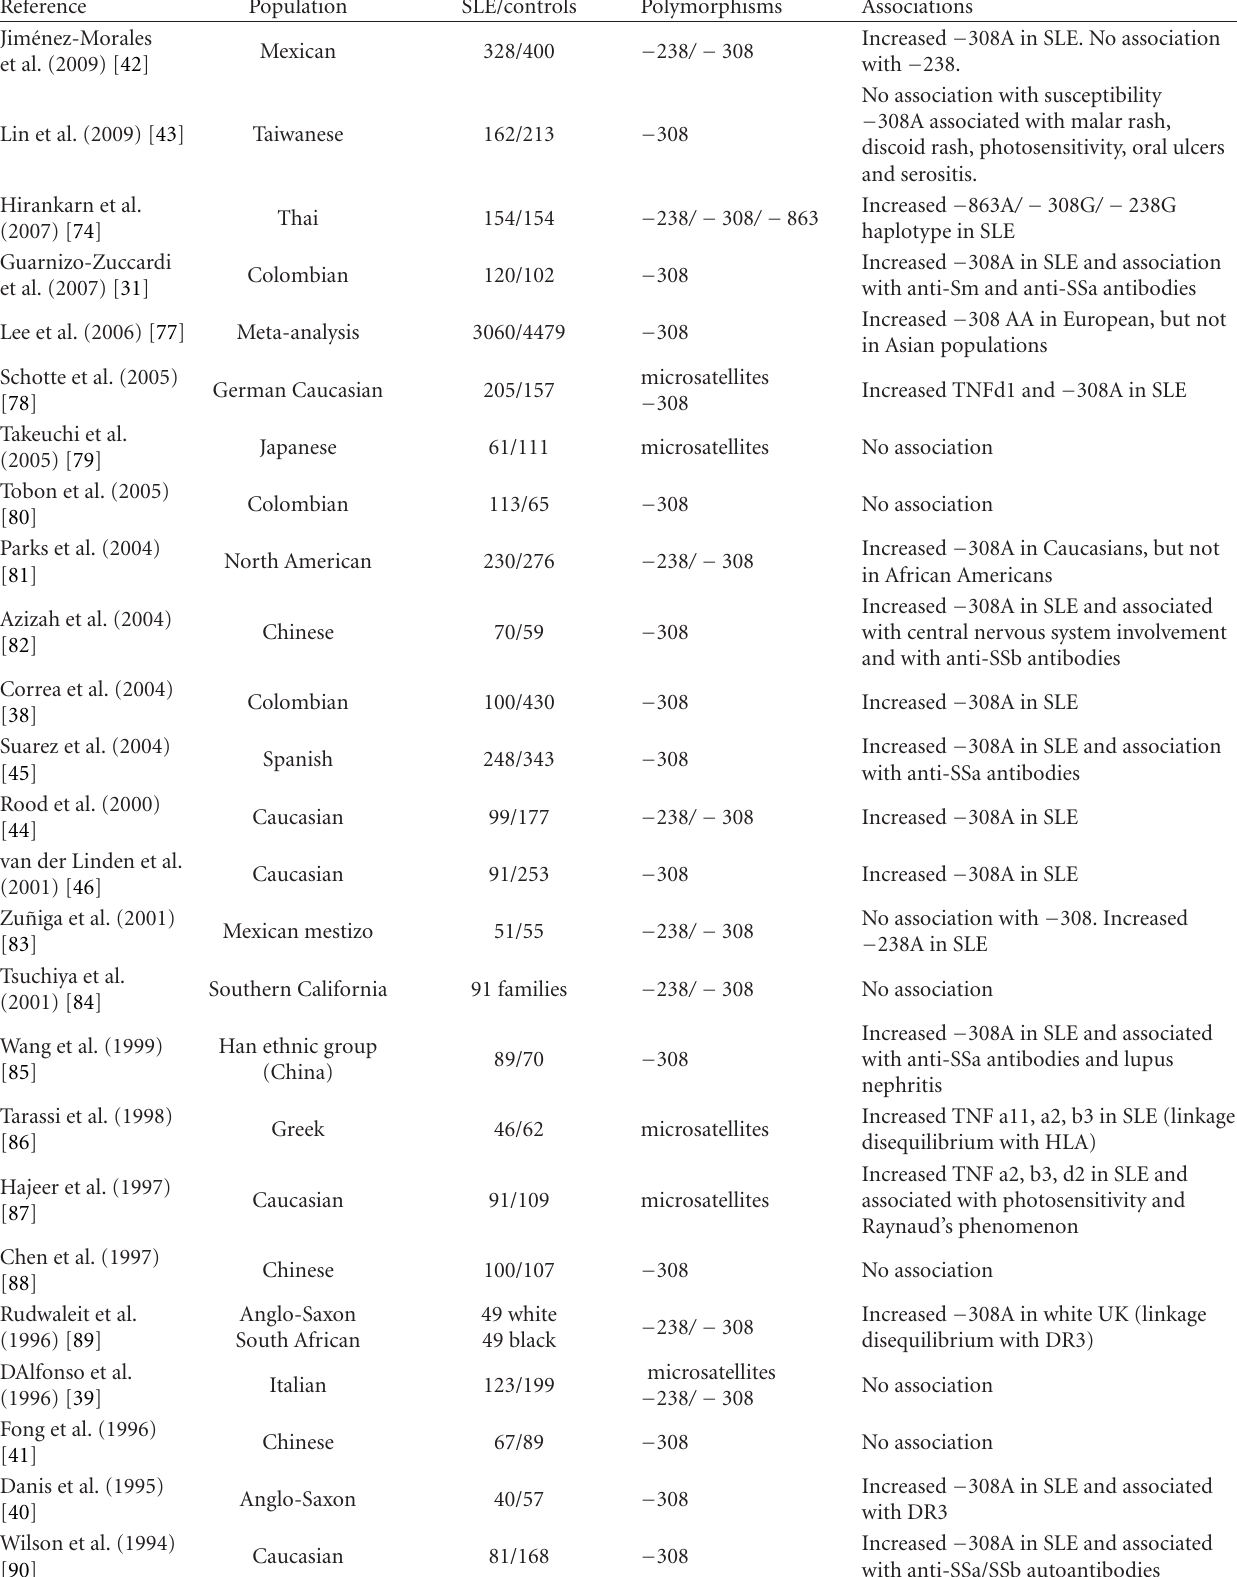
Table 3: Summary of association studies of TNF α promoter polymorphisms with